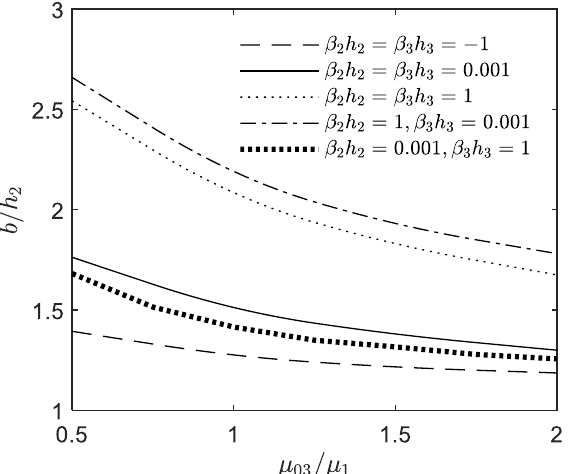
Figure 8. The dependencies of the non–dimensionalized receding contact half–length on the shear moduli ratio µ 03 / µ 1 for different inhomogeneity parameters β 2 h 2 and β 3 h 3 ( h 2 = h 3 , a / h 3 = 0.5 ) . The thickness of the interlayer can also regulate the receding contact half-length. Figure 9 focuses on the influence of the interlayer’s thickness on the receding contact half- length, while the inhomogeneity parameters of the top layer and the interlayer are equal. For a special case β 2 h 2 = β 3 h 3 = 0.001, the proposed model is reduced to a receding contact problem between a homogeneous layer and a homogeneous half-plane. The thickness of the homogeneous interlayer does not significantly influence the contact area. This indicates that a harder and thicker FG interlayer results in a large amount of receding contact, and therefore, a reduced peak contact pressure in Figure 9. The opposite is true for a soft FG interlayer. The thicker the soft FG interlayer, the smaller the receding contact half-length. This also leads to an increase in the maximum contact pressure.